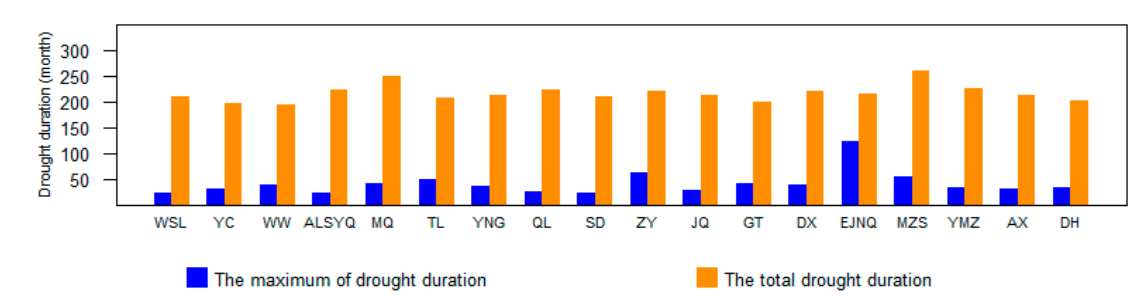
Figure 4. Mean drought severity and drought peak at each station.